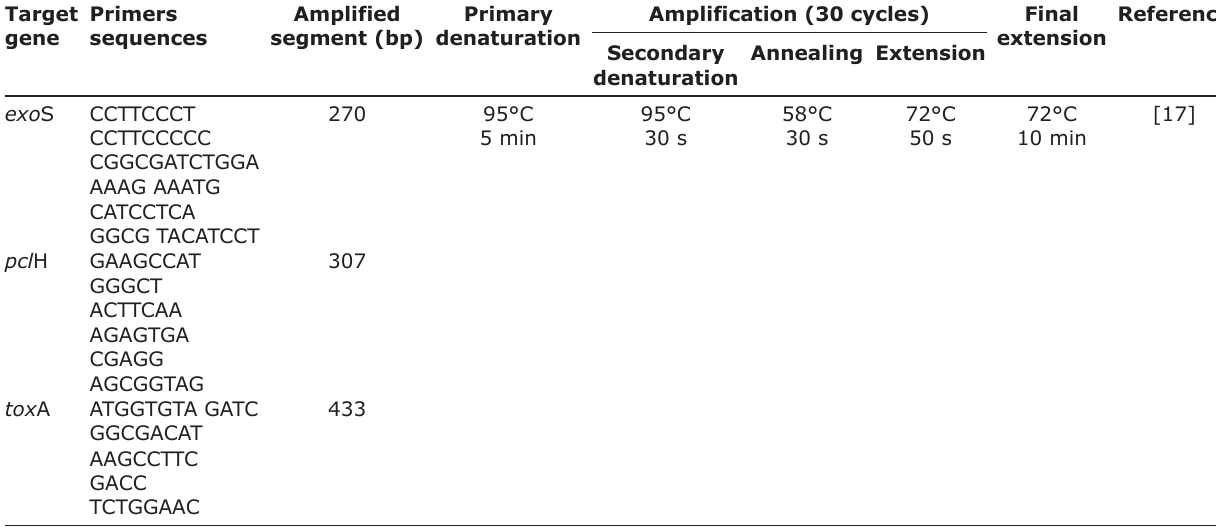
PCR=Polymerase chain